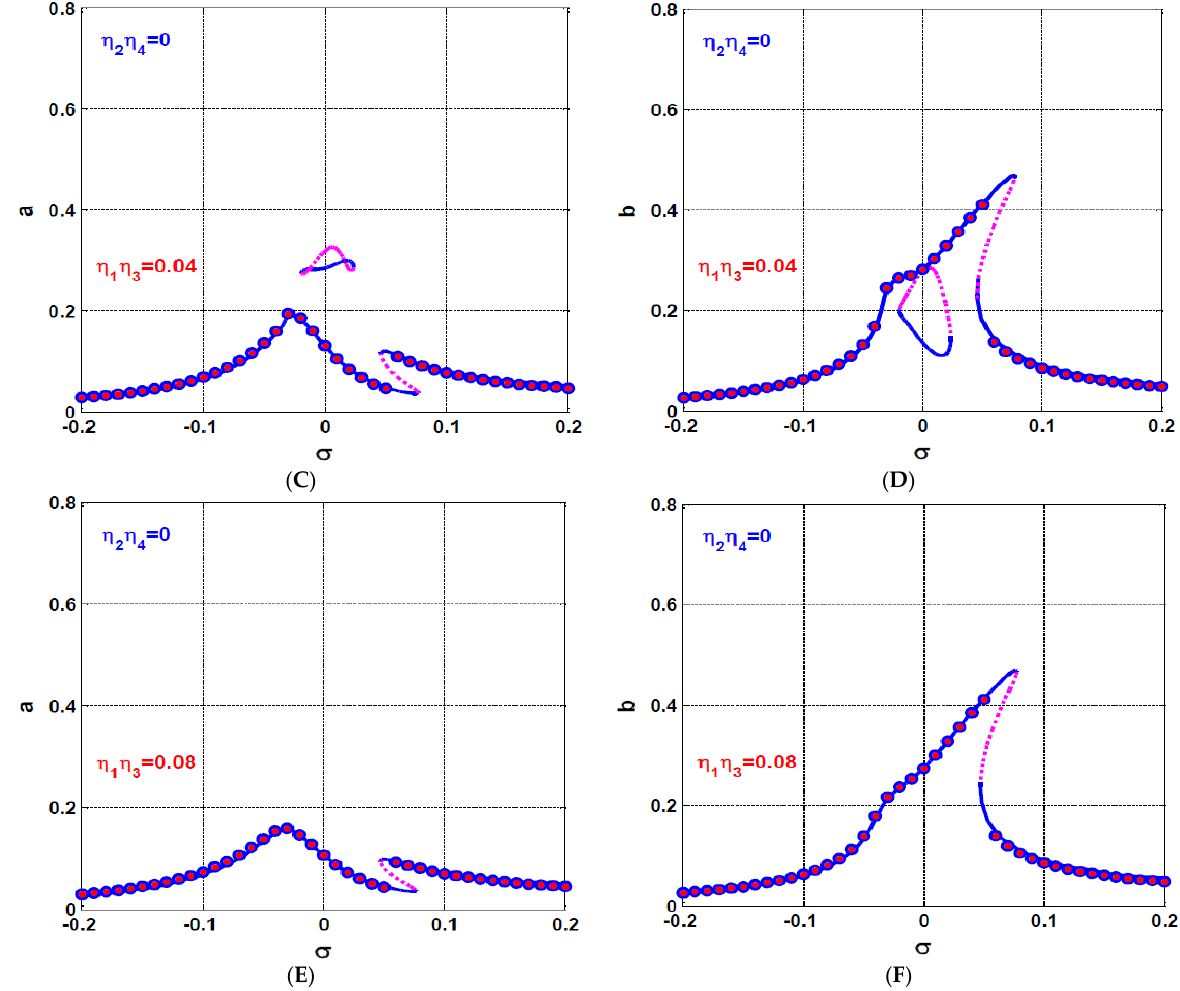
Figure 8. The rotor system 𝜎— response curve at three different values of the product of the control signal gain ( 𝜂 1 ) and feedback signal gain ( 𝜂 3 ) of the U-IRC (i.e., 𝜂 1 𝜂 3 = 0.01, 0.04,0.08 ) when turning off the V-IRC (i.e., 𝜂 2 𝜂 4 = 0.0 ): ( A , B ) the system oscillation amplitudes a and b when 𝜂 1 𝜂 3 = 0.01 , ( C , D ) the system oscillation amplitudes a and b when 𝜂 1 𝜂 3 = 0.04 , and ( E , F ) the system oscillation amplitudes a and b when 𝜂 1 𝜂 3 = 0.08 .